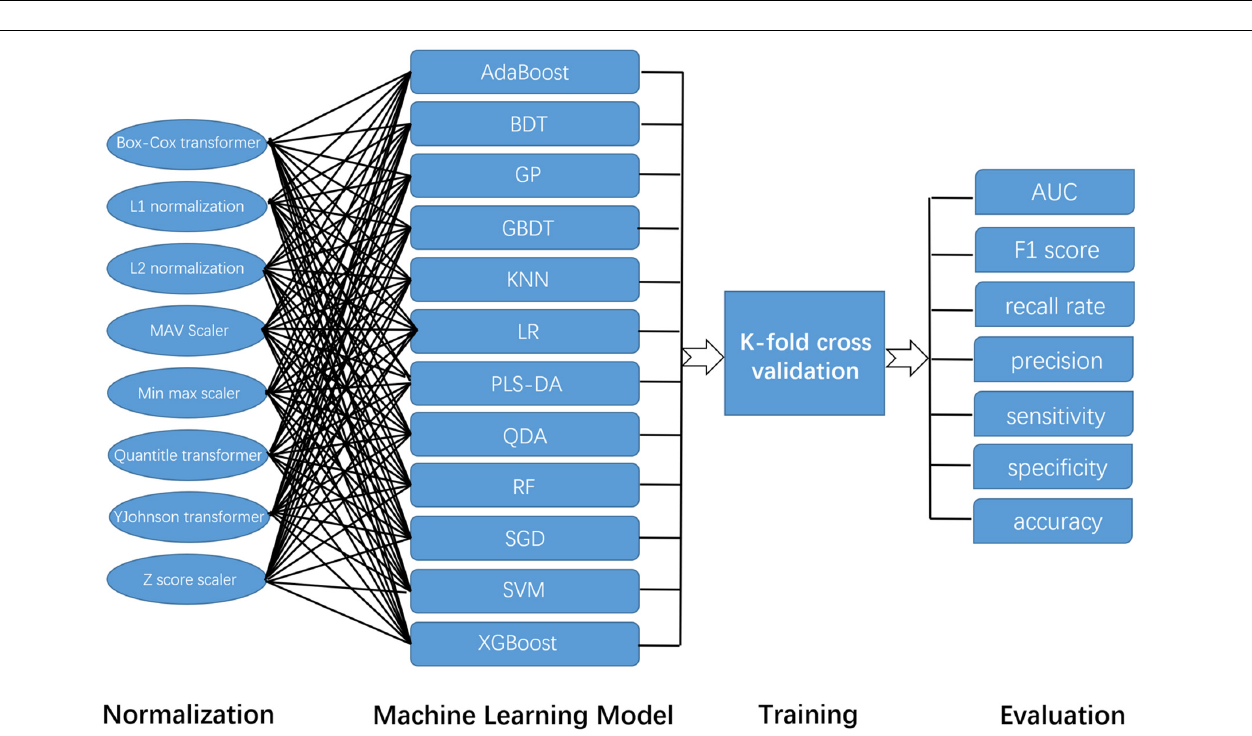
FIGURE 2 | The construction and evaluation of the machine learning model in this study. Because this study adopts a variety of normalization methods and machine learning models, their combination is shown in this figure.